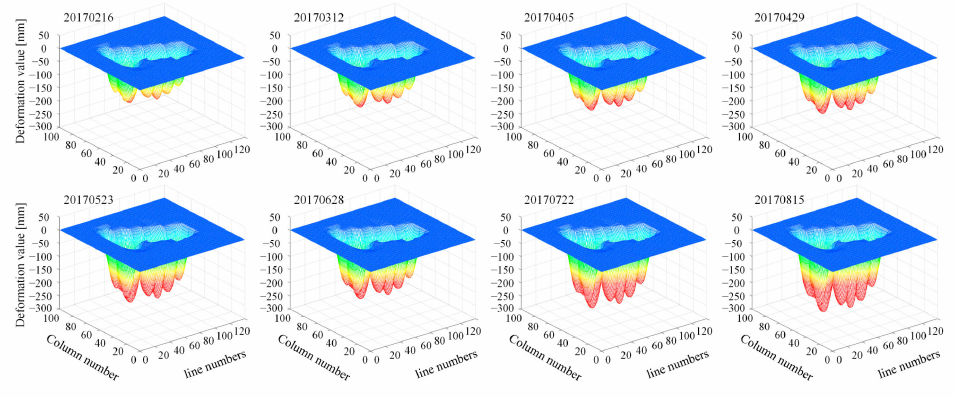
Figure 13. Three-dimensional scenes of the predicted subsidence based on CT-PIM (reference date: 15 June